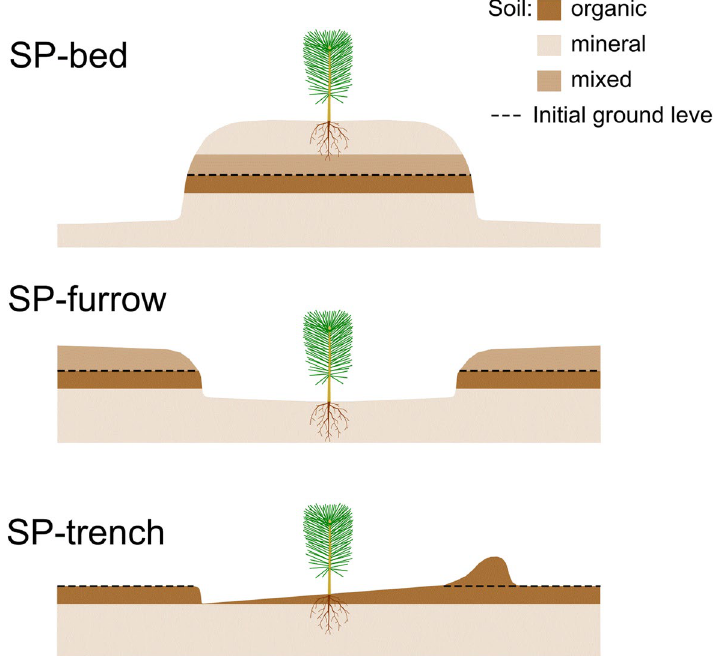
Fig. 2 Schematic description of three types of mechanical site preparation: bedding and planting on ridges (SP‑bed), plowing and planting in furrows (SP‑furrow), and disc trenching